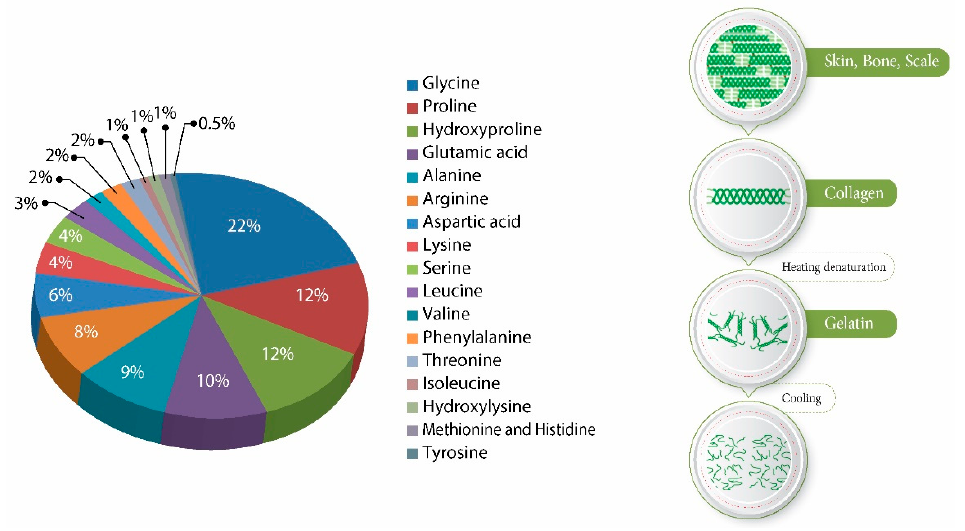
Figure 1. Gelatin composition and general overview of its production process.